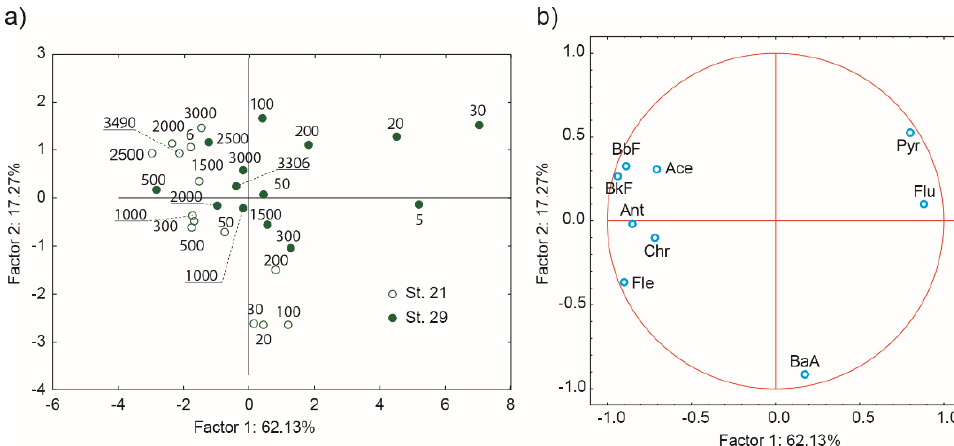
Figure 7. Principal component analysis of the deep water samples from the Japan Basin. ( a ) Score plot; ( b ) loading plot for DPAHs. The numbers correspond to the depth where the samples were taken.